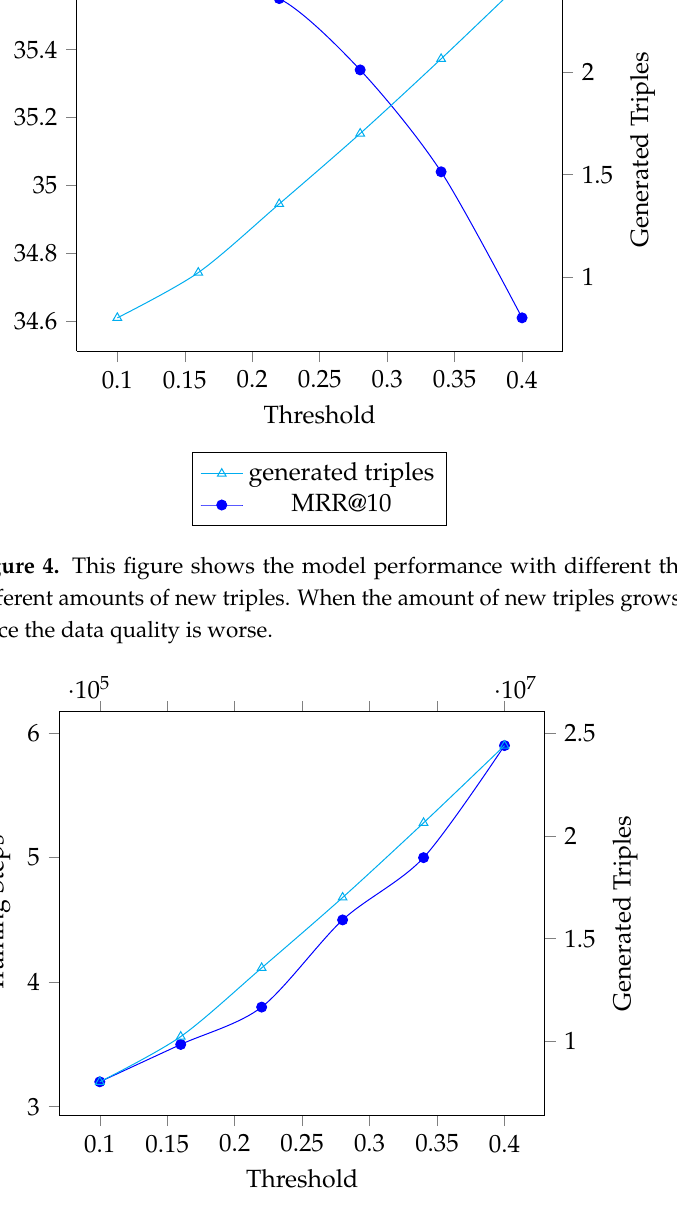
which presents different amount of new triples, the model costs much more computational resource when t is too big. Every 100,000 training steps cost about 17 hours for two NVIDIA Tesla V100 GPUs A with 16G RAM to train. Table 7. Data Augmentation Case. In the case, since there are lots of overlapping tokens ( ‘interest’ , ‘account’ , which are in bold type) between the original positive and negative, it is hard for the model to judge whether the positive and negative are similar through term frequency. We calculate the similarity between the generated query and the original query, the similarity score is lower than 0.1 (using cosine similarity), so we regard the original positive as the negative of the generated query and build a new